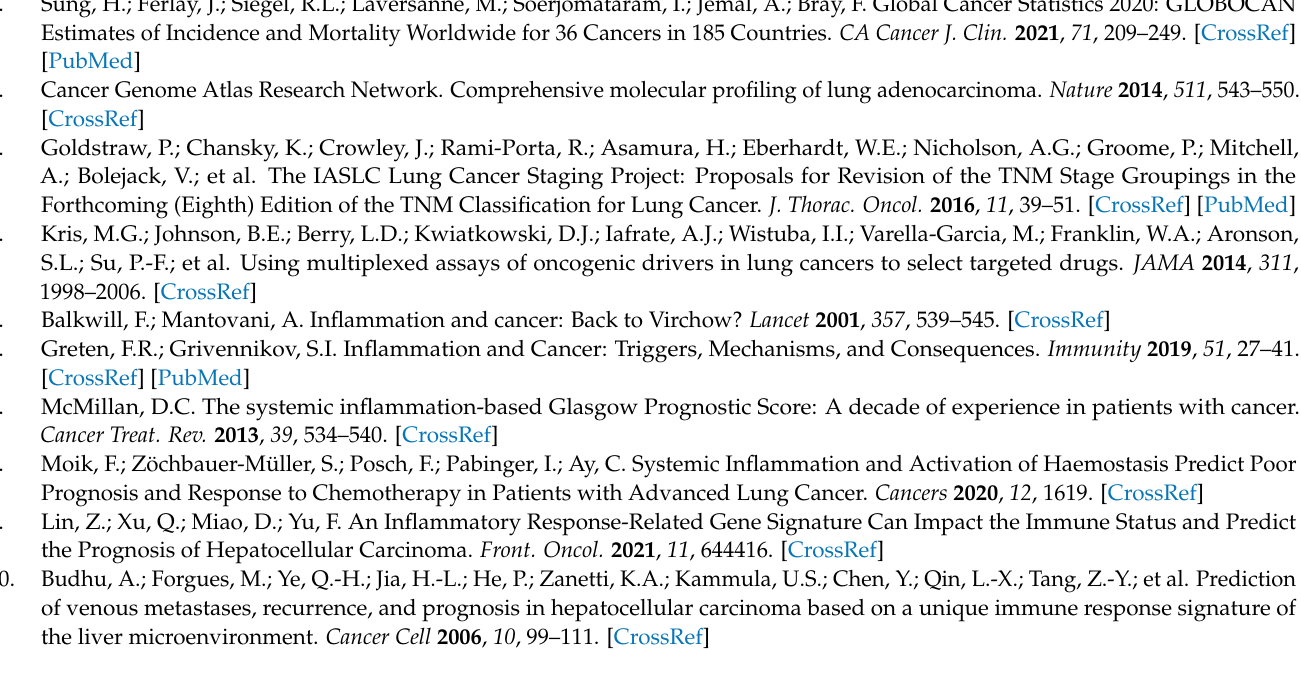
Table S2: The 263 chemotherapy drugs of FDA approved or on clinical trials; Table S3: The primers of ten-prognostic genes; Table S4: Protein antibody stock